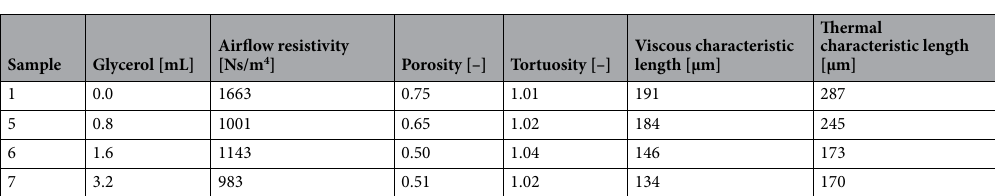
Table 6. Glycerol concentration variation—JCA model